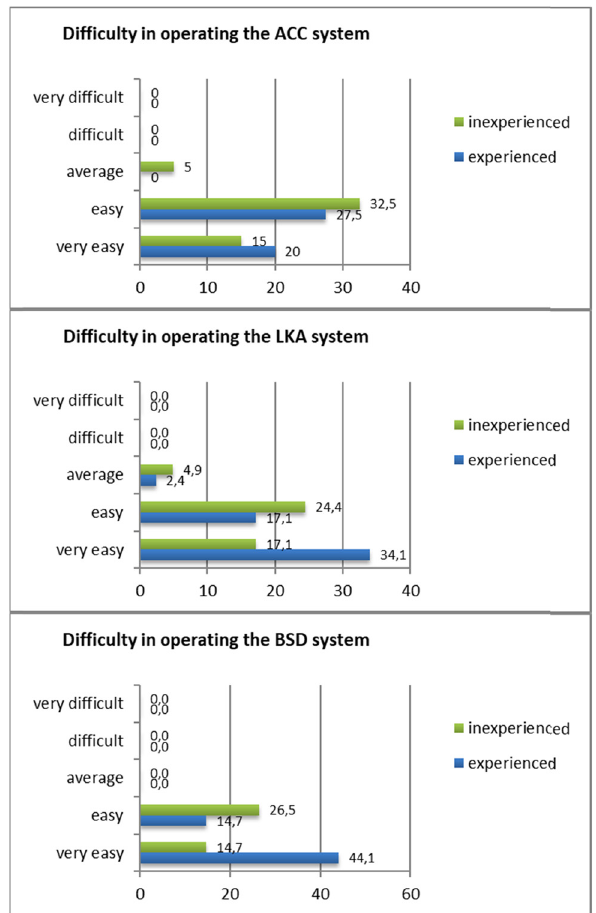
Figure 3: Di ffi culty level in operating driver - assistance systems by experienced and inexperienced drivers ( % ) . Source: author ’ s own study.